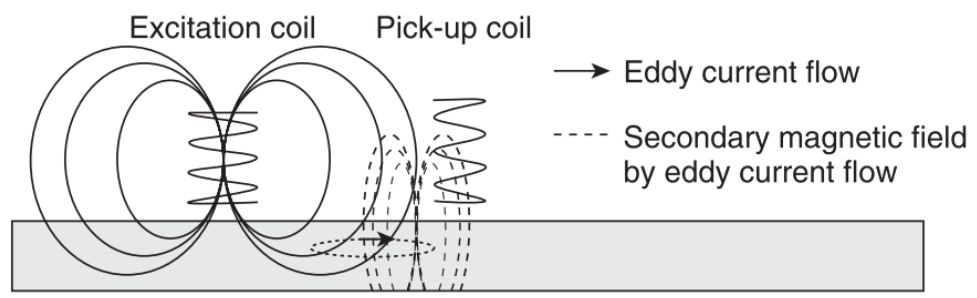
Figure 7. The principles of eddy current testing. (Reprinted with permission from ref. [45]. Copyright 2013 Elsevier).